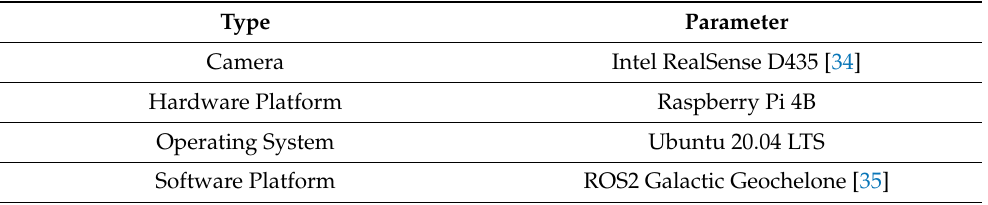
Table 1. The Experimental Setup Parameters.